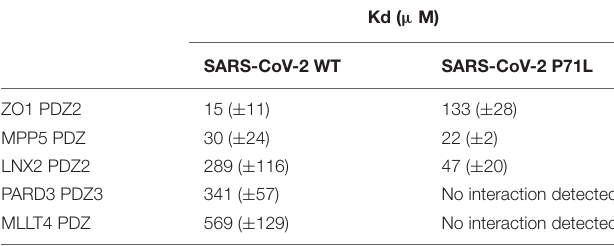
TABLE 3 | Kd values between the E protein PBM of SARS-CoV-2 WT and of the P71L mutant for the selected PDZ